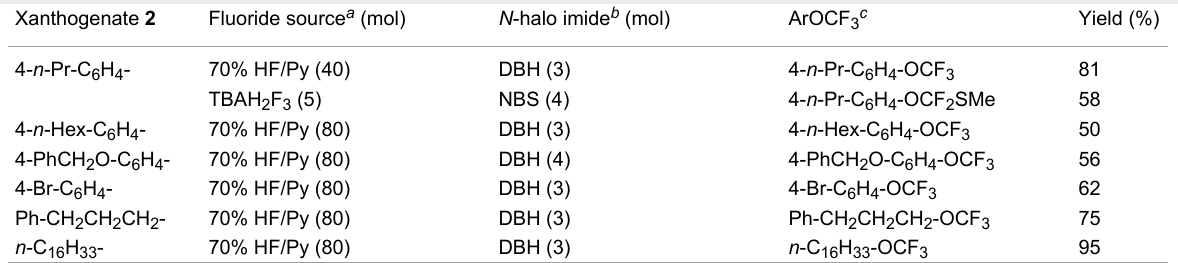
Table 5: Oxidative desulfurization-fluorination towards ROCF 3 compounds. Xanthogenate